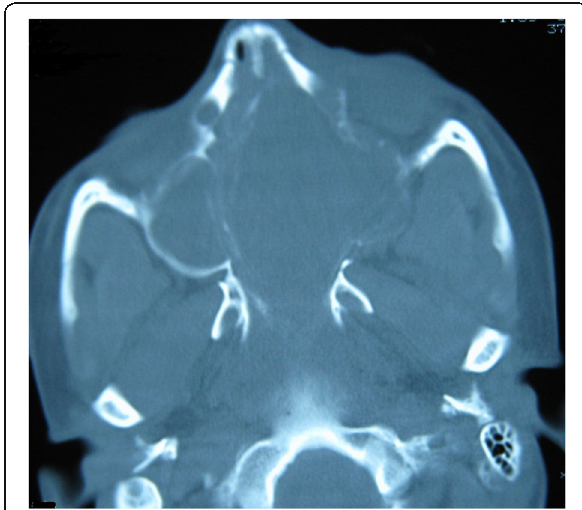
Fig. 1 Axial CT scan of the paranasal sinuses showing a mass in the left nasal cavity ballooning the whole nasal cavity with compression of the nasal septum and orbit and extending to the nasopharynx